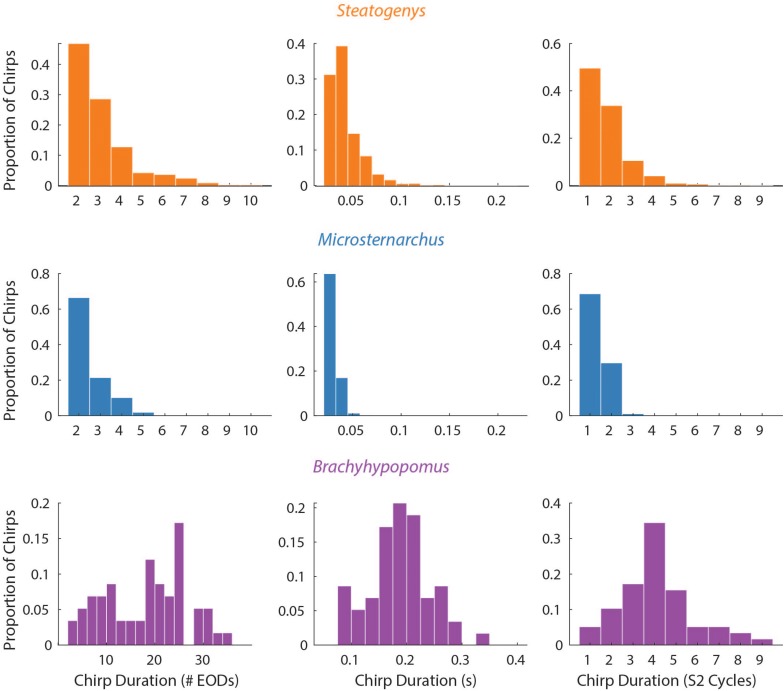
Probability histograms of all chirps (pooled) in all three species, plotted in terms of three measures of chirp duration: number of EODs (left), time (middle), and number of S2 cycles affected (right). Chirp duration expressed as S2 cycles were the only metric that allows comparison across species on the same scale.